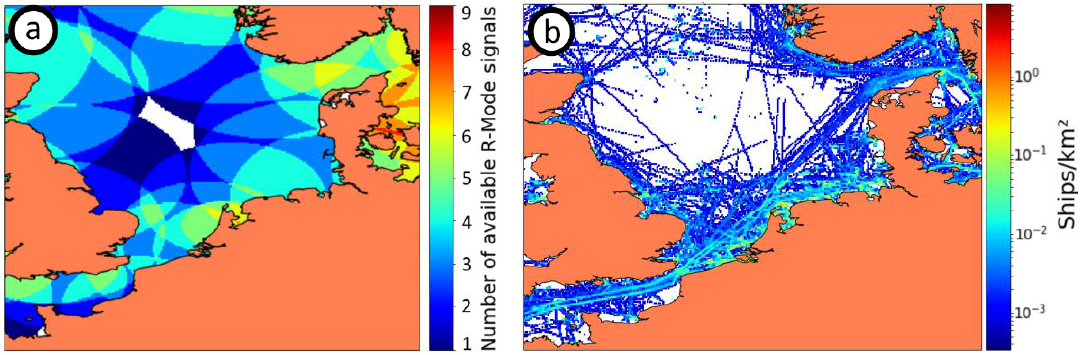
Figure 11. Comparison between the potential R-Mode coverage in the North Sea ( a ) and the traffic density in the same area ( b ).